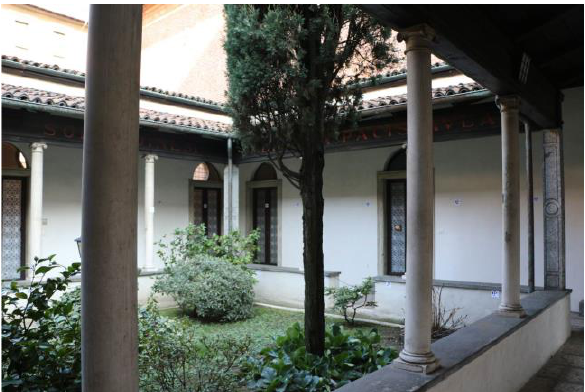
Figure 1. View of the Cloister of the